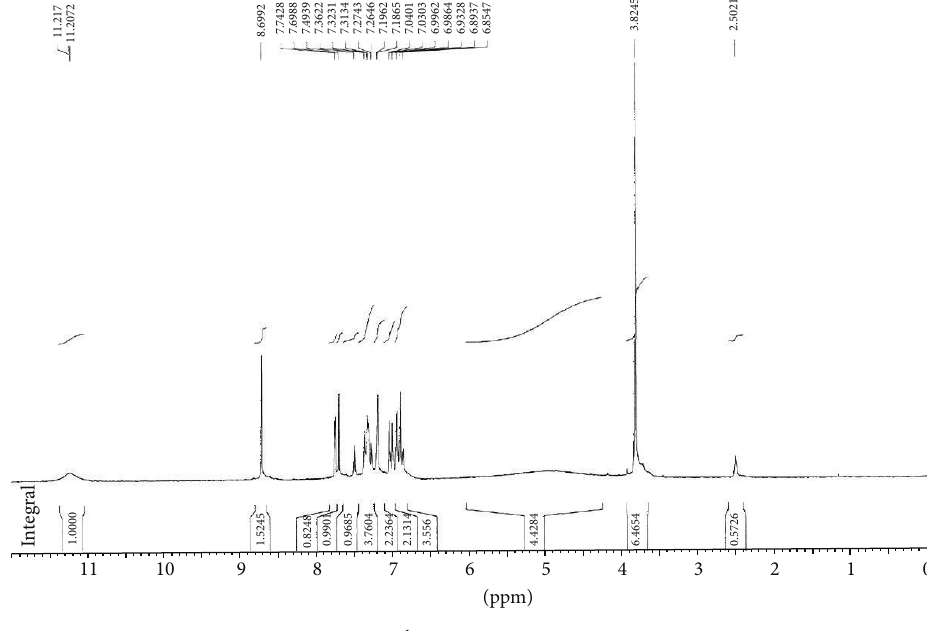
Figure 1: 1 H NMR spectrum of ligand HL.